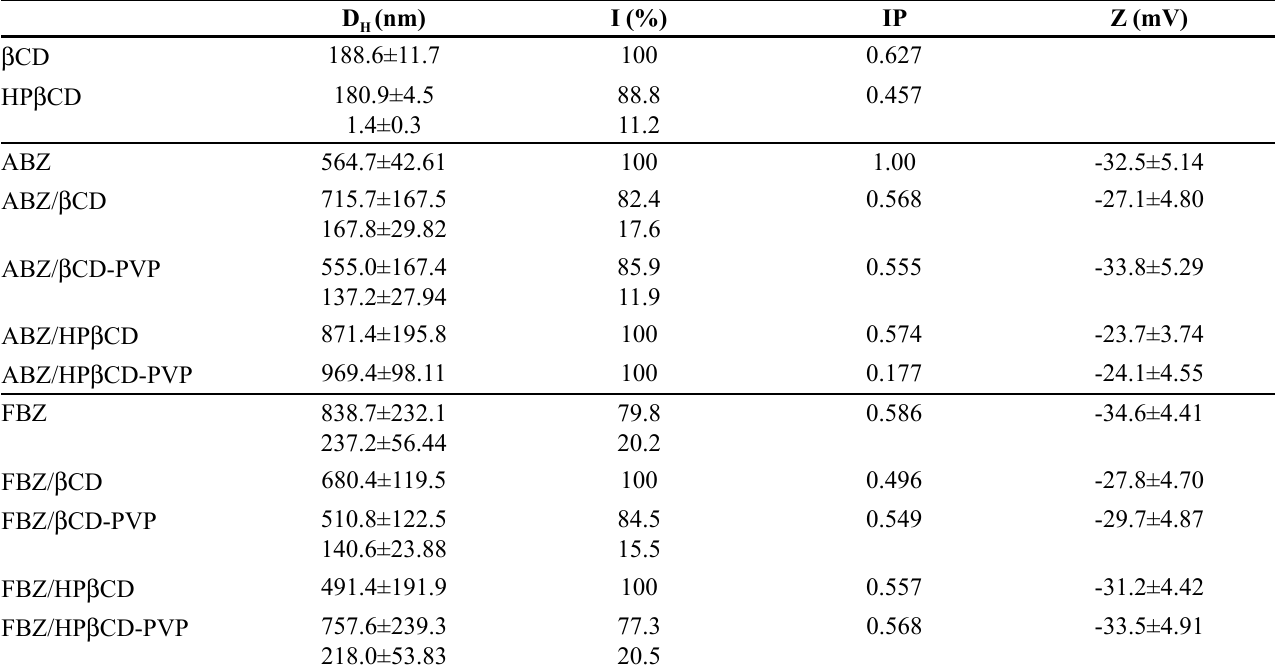
TABLE IV - Mean values of hydrodynamic radius ( R and binary and ternary complexes